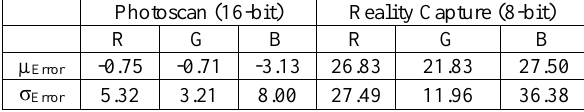
Table 5. 16-bit colour errors (measured in tones) of a colour chart measured before and after processing the images in Agisoft Photoscan (2018) and Capturing Reality Capture (2018)